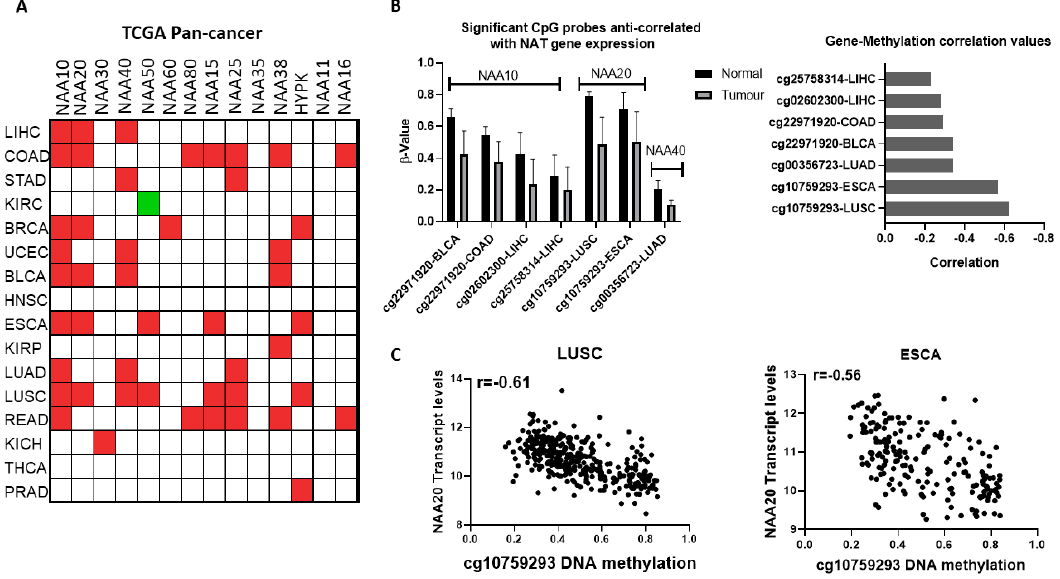
Figure 3. Transcriptional and epigenetic deregulation of NAT genes between normal and tumour tissues; ( A ) Comparison of NAT transcript levels in tumour and adjacent normal tissue from TCGA pan-cancer study. Significantly ( p < 0.05) upregulated transcripts are depicted as red boxes, downregulated transcripts are depicted as green colour boxes; ( B ) DNA methylation probes displaying significant alterations in their methylation levels and anticorrelation with NAT transcript levels in Bladder Urothelial Carcinoma (BLCA), Colon adenocarcinoma (COAD), Liver hepatocellular carcinoma (LIHC), Lung squamous cell carcinoma (LUAD), and Oesophageal carcinoma (ESCA) tumours; ( C ) Plots of NAA20 transcript levels ( Y -axis) vs. DNA methylation levels for probe cg10759293 ( X -axis) in LUSC and ESCA tumours.